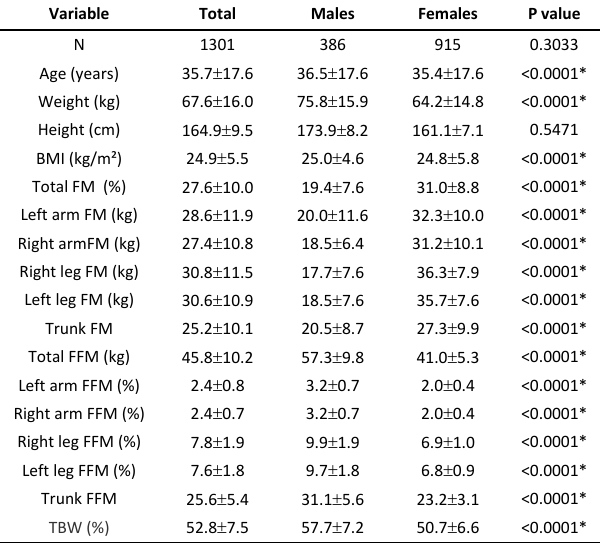
Table 1: Anthropometric and body composition characterization of the study